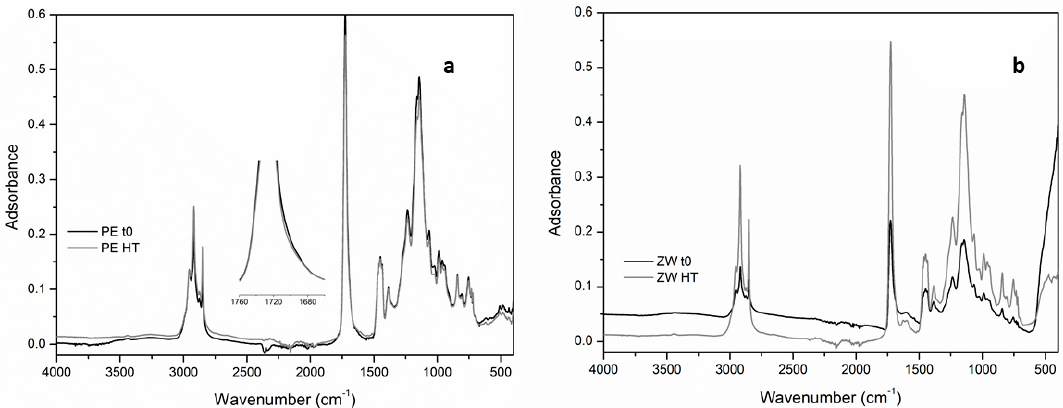
Figure 6. FT-IR-ATR spectra of: ( a ) Edelwachs and ( b ) zinc white mock-ups before ageing (t0) and after high temperature ageing procedure (HT).